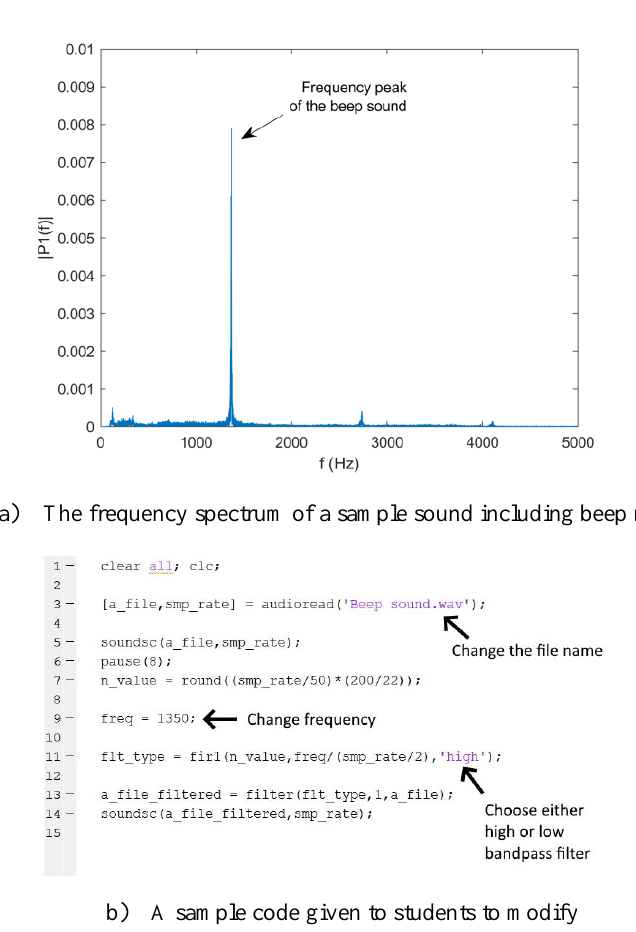
Fig. 4. An example of a bandpass filter application as an electrical engineering